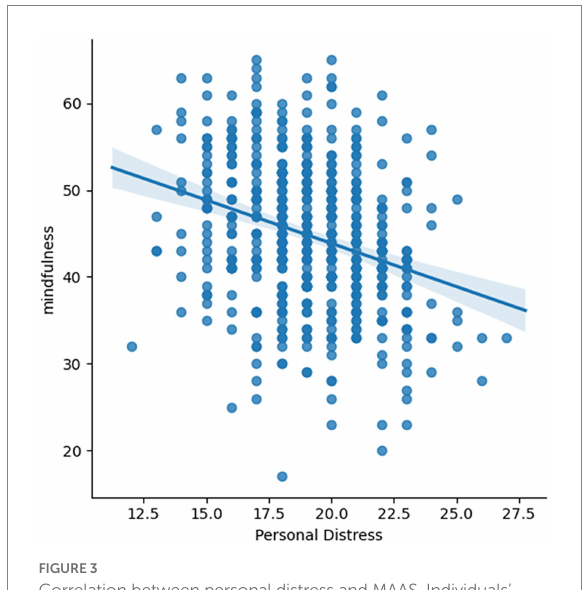
FIGURE 3 Correlation between personal distress and MAAS. Individuals’ personal distress is negatively correlated with MAAS scale [t(475) = − 5.493, p <